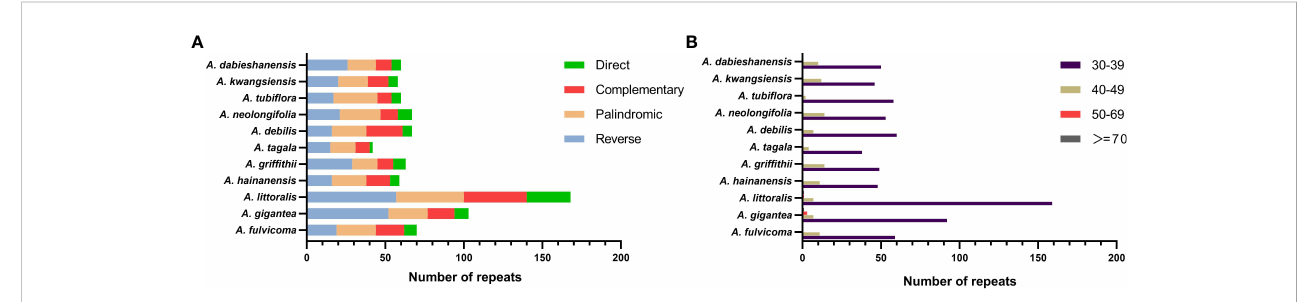
FIGURE 2 Long repeat sequences in the chloroplast genome of 11 species of Aristolochia . (A) Frequency of four types of repeats; (B) Length of repeat sequences.